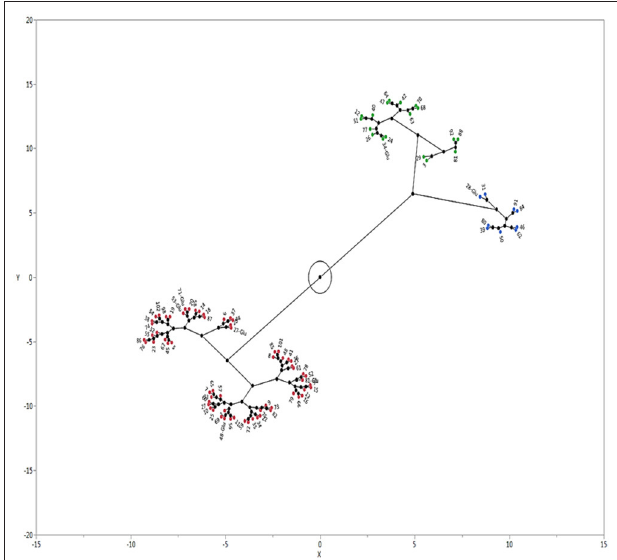
FIGURE 3 | Castellation plot showing three clusters of Echinochloa species from Arkansas, USA based on germination capacity. The accessions were grown in a common garden in Fayetteville, Arkansas. Seeds were after-ripened for 180 d at 25 ◦ C and germinated in a growth chamber at 32 ◦ C day/23 ◦ C night temperature with 12-h photoperiod. Cluster 1 = E. colona (red); Cluster 2 = E. crus-galli (green); cluster 3 = E. muricata (blue).